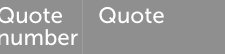
TABLE 2 Illustrative quotes for each